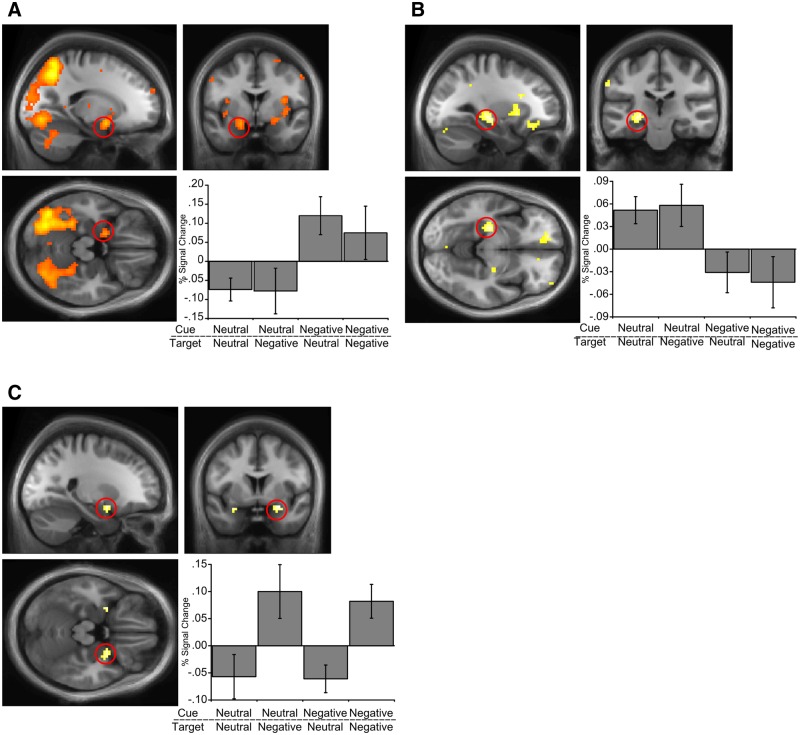
Retrieval activity related to item and associative memory (percent signal change figures show associative hits minus misses for each condition) across cue and target conditions. (A) Activity in the amygdala was increased for negative item memory (hits minus misses) compared with neutral item memory (P < 0.05 FWE SVC; −18, 0, −15). (B) We saw a significant activation in the left hippocampus (P = 0.07 FWE SVC; −27, −24, −9) for associative memory (associative hits minus misses) when cued with a neutral item vs a negative item. (C) Activity in the right amygdala increased during successful associative memory (associative hits minus misses) when retrieving a negative target associate compared with a neutral target (P < 0.05 FWE SVC; +30, +3, −15). Effects displayed on group average brains and thresholded at P < 0.005 uncorrected for display purposes.